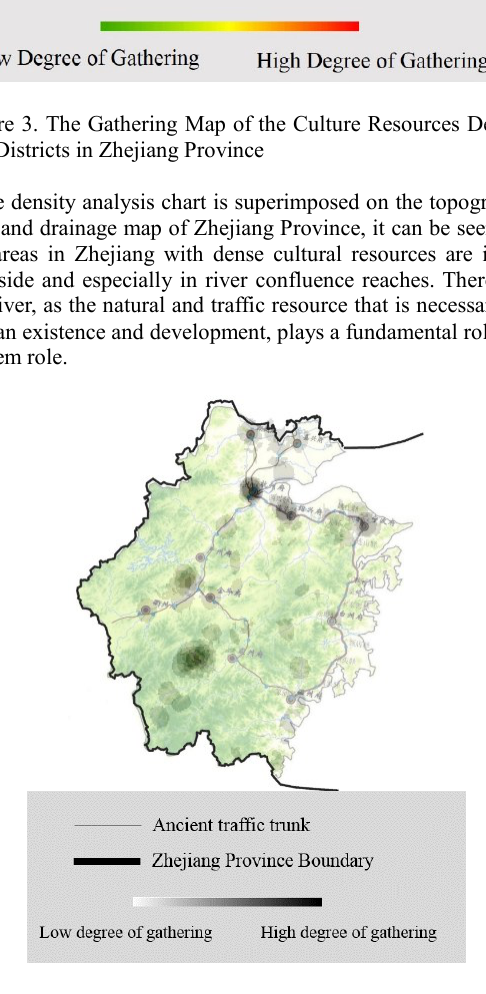
Figure 4.Overlay map of cultural resources and ancient traffic